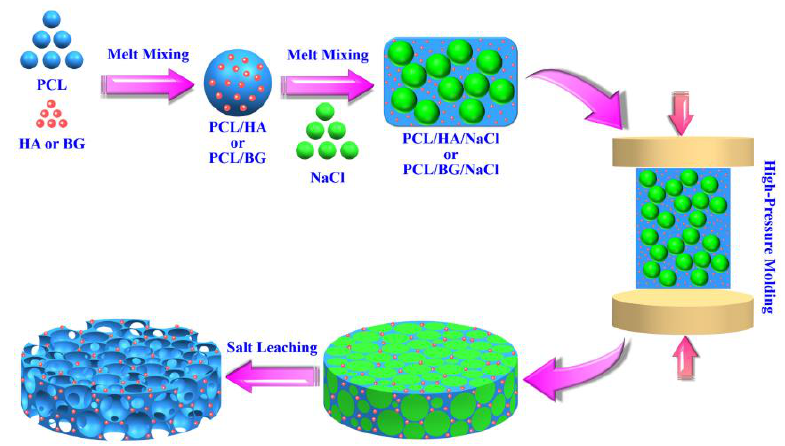
Figure 7. Schematic diagram of fabricating porous PCL composite scaffolds. Reproduced from [60]. Table 2. Principal properties of extrusion-injection molding investigations. With * the compression, ** tensile (not filled cells mean no data).